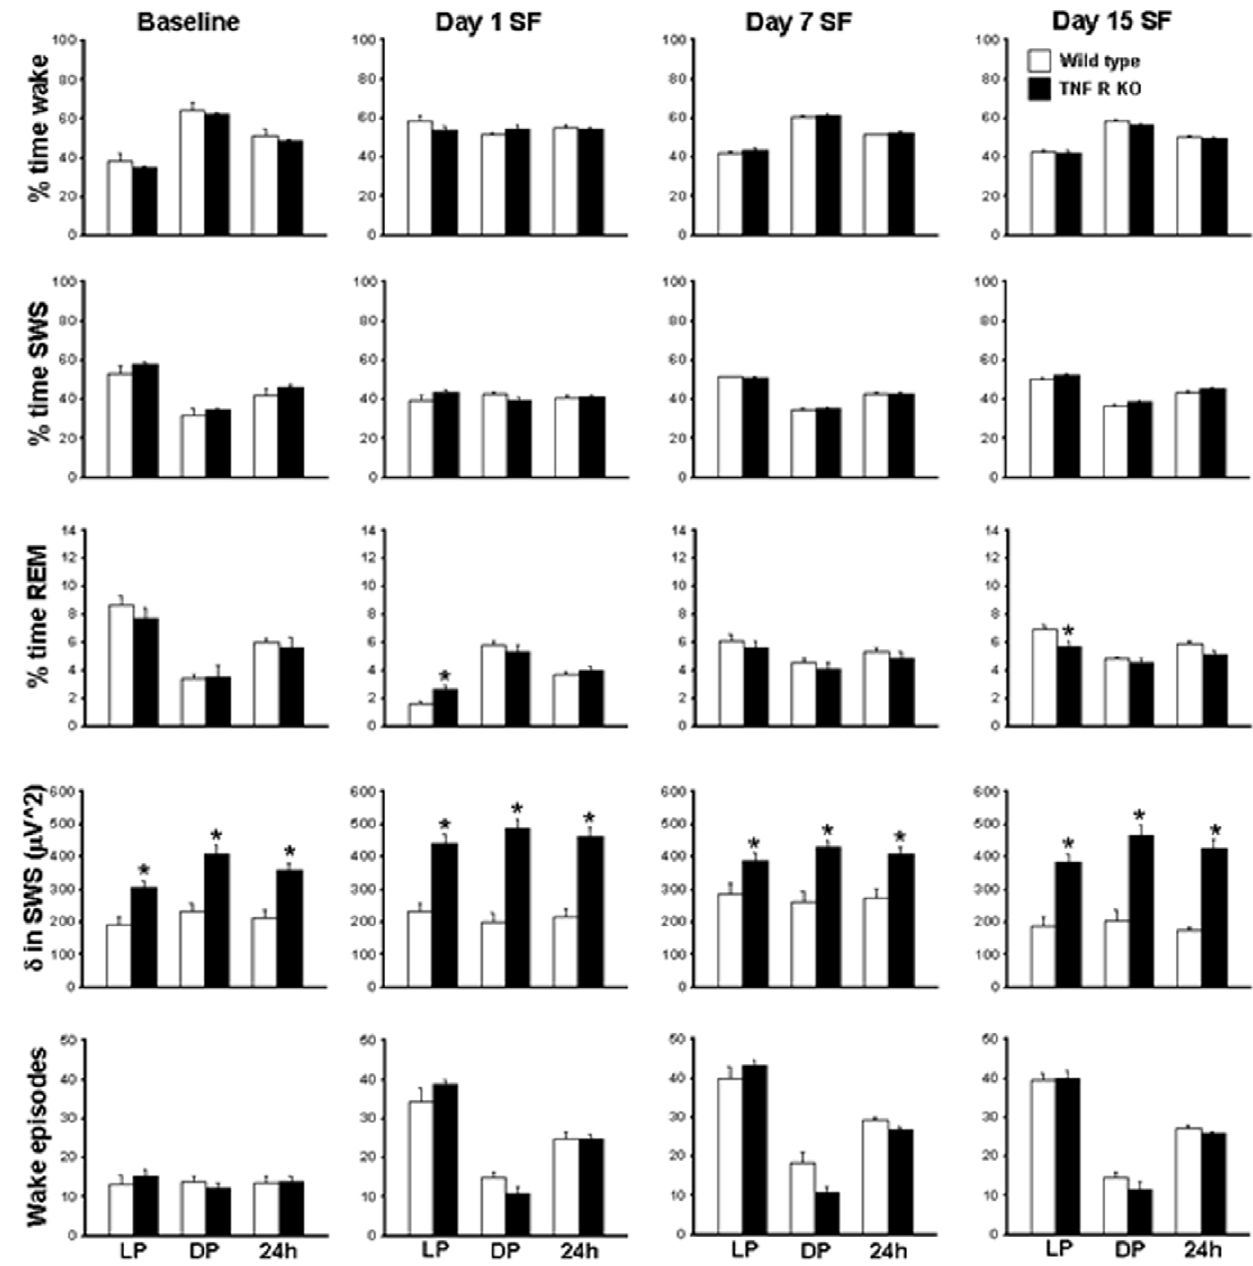
Figure 2. Sleep-wakefulness, EEG delta power in SWS and wake episodes (light period, dark period and total (24 h) in wild type and TNF R KO mice. Comparison of sleep parameters in WT and TNFR KO mice during light (LP), dark (DP) and 24 hours (24 h) period at baseline, day 1, day 7 and day 15 of SF in WT (open bars) and TNF R KO mice (filled bars). LP, light period; DP, dark period. *p , 0.05. *=comparison between baseline and SF during respective post-fragmented days.